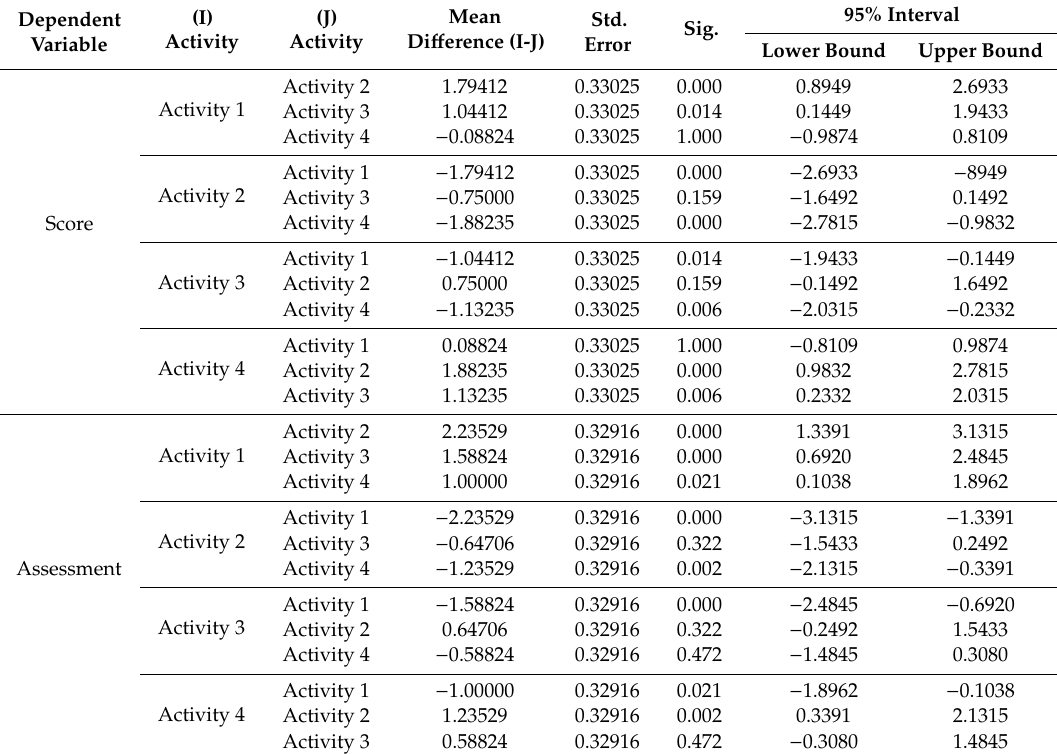
Table 10. Summary of Bonferroni test for type of e-learning activity.